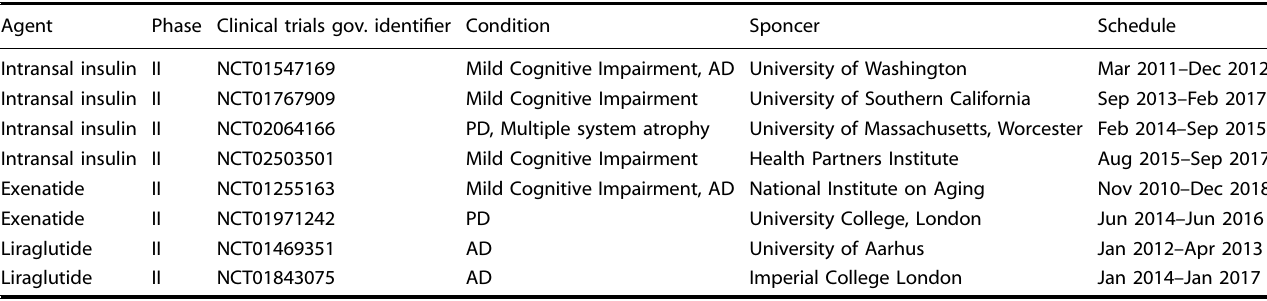
Table 2. Examples of recent clinical trials of the “ anti-insulin resistance ” therapy in AD and PD